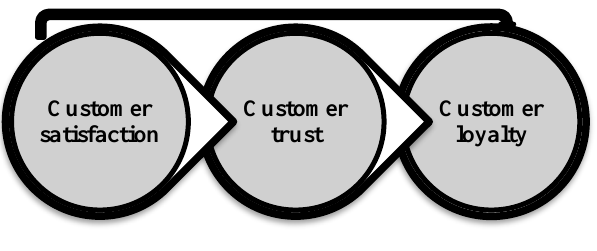
Fig. 1. Interaction model of satisfaction, trust and loyalty. (Trif, 2013).